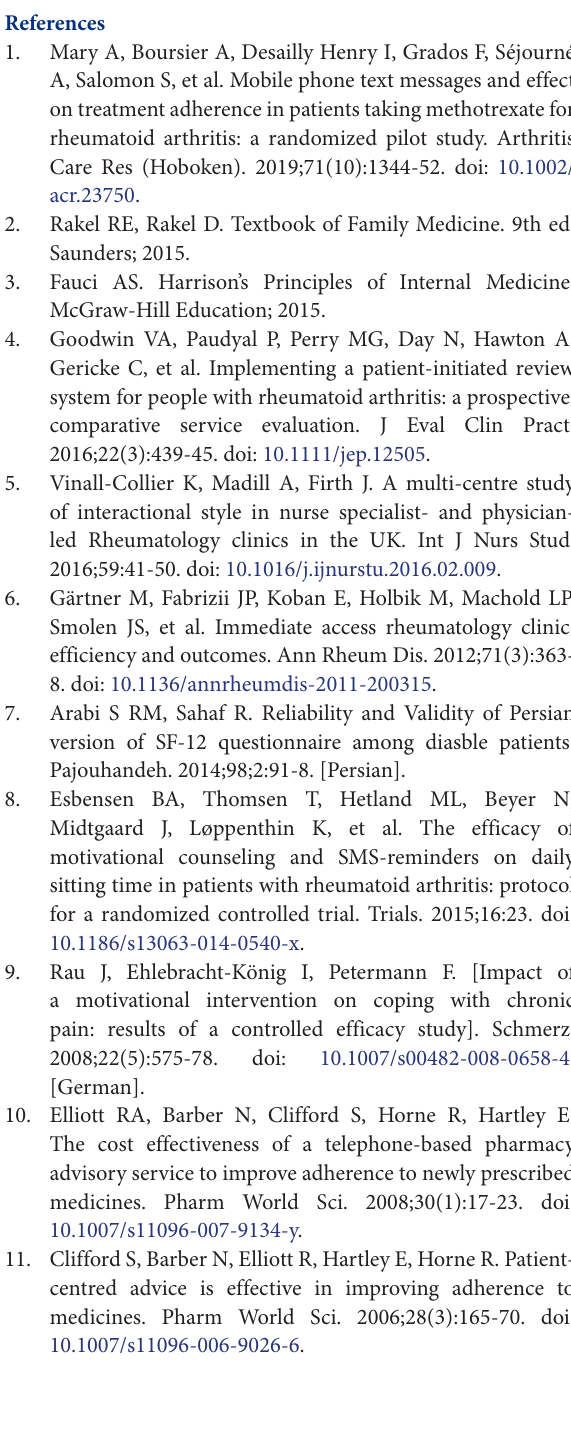
Table 3. Mean Score of Patients’ Quality of Life Before and After Treatment in Both Intervention and Control Groups